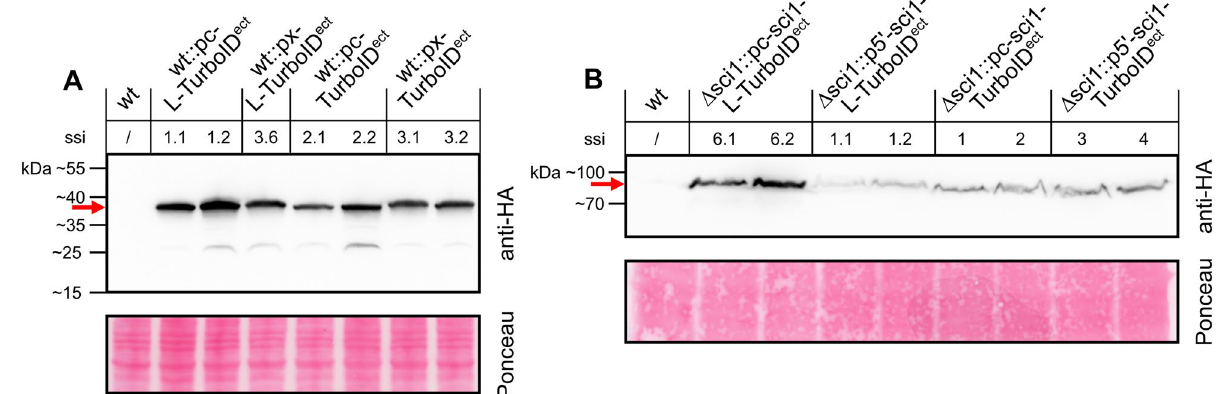
Figure 2. Western blot detection of TurboID constructs using an anti-HA antibody. Expression of the ( A ) free TurboID and ( B ) SCI1-TurboID fusion proteins in S. macrospora wt and Δsci1 was determined by Western blot hybridization using a monoclonal anti-HA antibody, which detects the C-terminal 3xHA tag of TurboID. Red arrows indicate ( A ) free TurboID (38.5 kDa) and ( B ) SCI-TurboID fusion proteins (71.6 kDa). Expression of the constructs is controlled by either the ccg1 overexpression promoter from N. crassa (pc), the native sci1 promoter (p5’), or the xylose inducible Smxyl promoter (px) 19 . Untransformed wt was used as negative control. S. macrospora strains were grown in liquid BMM for 3 days at 27 °C. 18 µL of crude protein extract were loaded, and Ponceau red staining was used as loading control. Blots and Ponceau red staining in ( A,B ) show the identical membrane, exposure was identical for all parts of the gel. Figure shows cropped blots. Full length blots and Ponceau red staining are depicted in Supplementary Fig. S2. ect, ect opically integrated; ssi, s ingle- s pore i